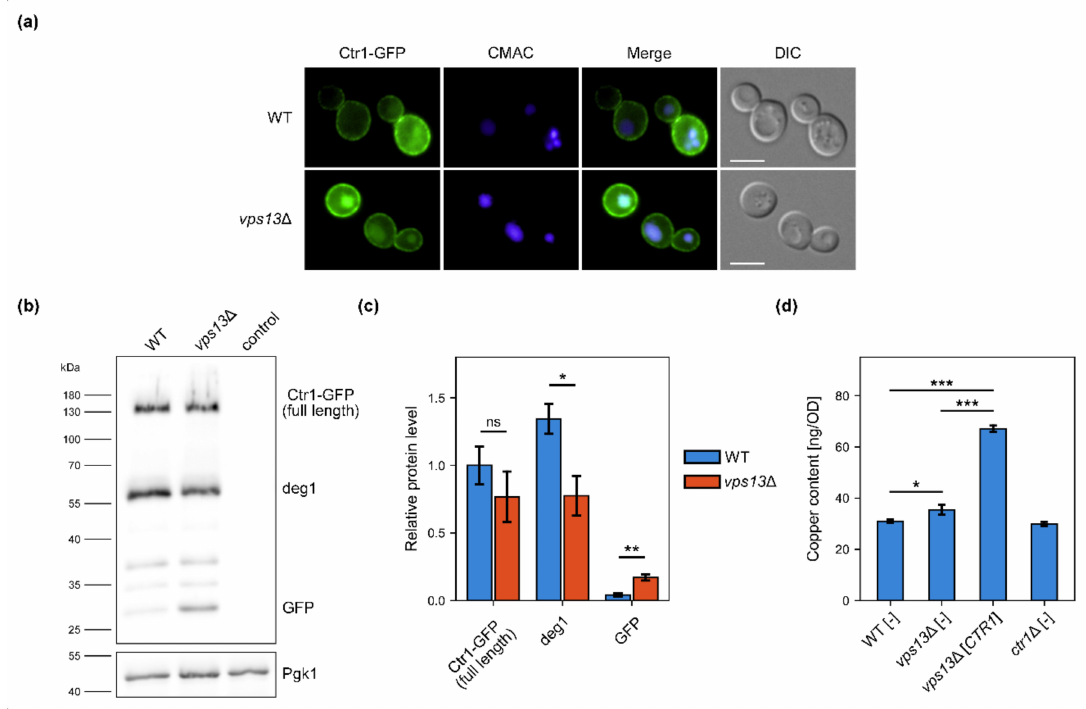
Figure 2. Degradation of Ctr1–GFP and copper level are increased in vps13 ∆ . ( a ) Fluorescence microscopy images of wild type and vps13 ∆ cells with GFP-tagged Ctr1 protein. Vacuoles were stained with CMAC. Scale bar 5 µ m. ( b ) Western blot analysis of protein extracts obtained from wild type and vps13 ∆ cells with GFP-tagged Ctr1 protein. Anti-GFP antibody was used for protein detection. Extract from yeast cells without GFP tag was used as a negative control (marked as control). Phosphoglycerate kinase 1 (Pgk1), detected with anti-Pgk1 antibody, was used as a loading control. ( c ) Quantification of western blot results. Relative levels of Ctr1–GFP, deg1, and GFP (in relation to Pgk1) are shown. Mean of the measurements for Ctr1–GFP in wild type cells was set to 1. Results were analysed by two-tailed Student’s t -test ( n = 3, ns p > 0.05, * p < 0.05, ** p < 0.01). Error bars represent SD. ( d ) Copper levels measurement in WT[-], vps13 ∆ [-], vps13 ∆ [ CTR1 ] and ctr1 ∆ [-] strains. Yeast were cultivated in YPD + CuSO 4 media. Copper content was measured by ICP-AES. Obtained results were analysed by ANOVA followed by Tukey’s multiple comparison test ( n = 3, * p < 0.05, *** p <